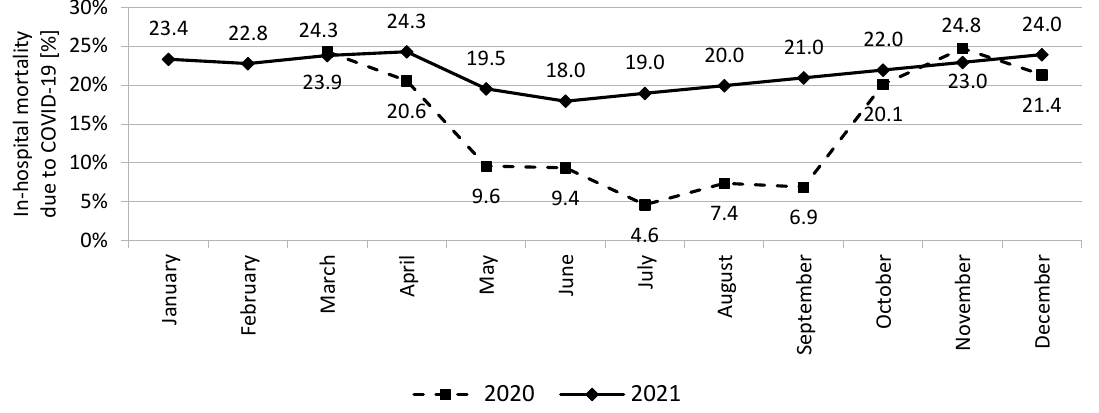
Figure 1. In-hospital mortality due to COVID-19 in the Silesian voivodeship in particular months of both years (2020 and 2021).